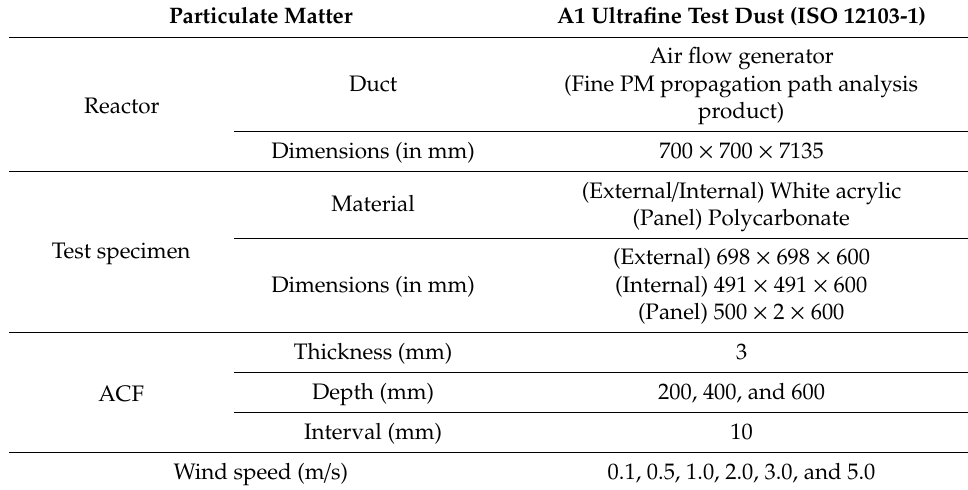
Table 1. Summary of the activated carbon fiber (ACF) performance experiment.